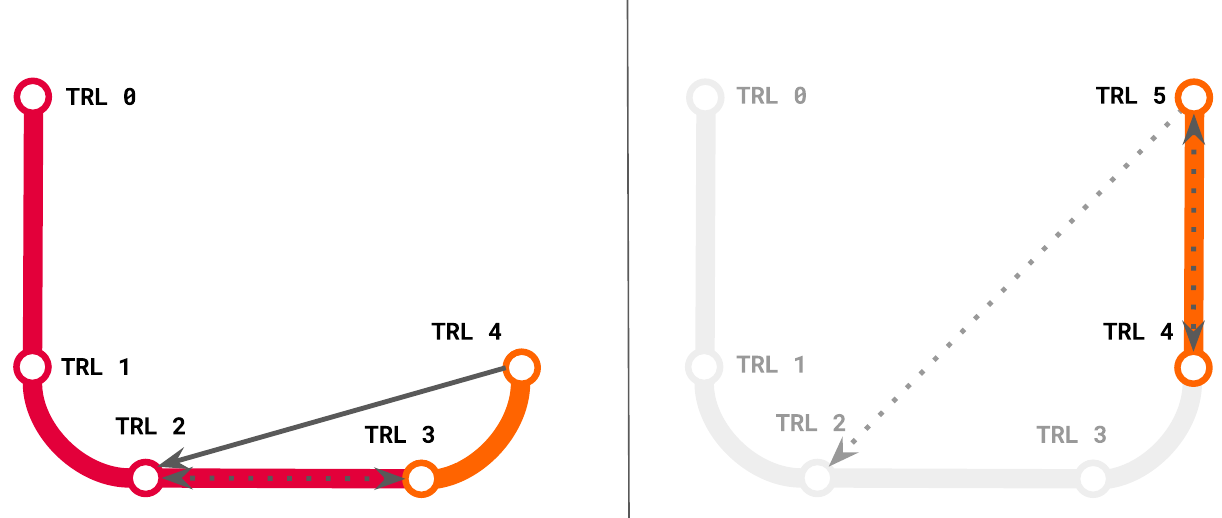
switchback to R& D levels that the team have not encountered and may not be equipped for. In the right diagram we show a common review switchback from Level 5 to 4 (staying in the prototyping phase (orange)), and a switchback (faded) that should not be implemented because the prior level was not explicitly done; level 2 is squarely in the research pipeline